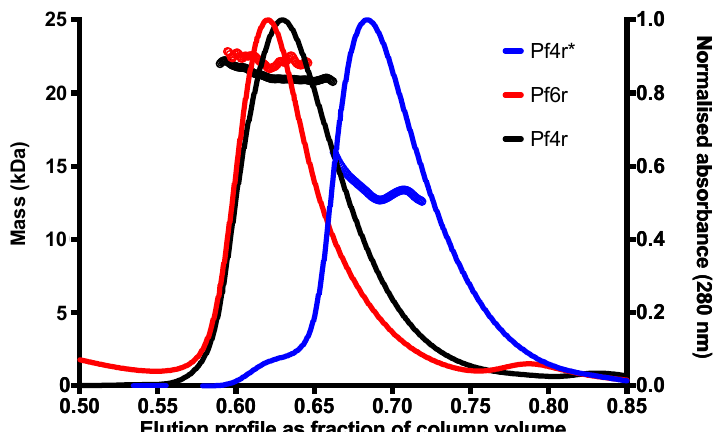
Figure 4. Pf4r (red), Pf4r* (blue) and Pf6r (black) elution profiles on SEC with molecular mass determination by MALS. Markers across the peaks represent the molar mass distribution (open circles, left axis, kDa) of the protein species within the peak as determined in-line MALS (Pf4r 21 kDa, Pf4r* 13.7 kDa and Pf6r 21.9 kDa). Theoretical masses of Pf4r and Pf4r* are 10.5 kDa (21 kDa dimer), and Pf6r is 11.2 kDa (dimer 22.4 kDa).